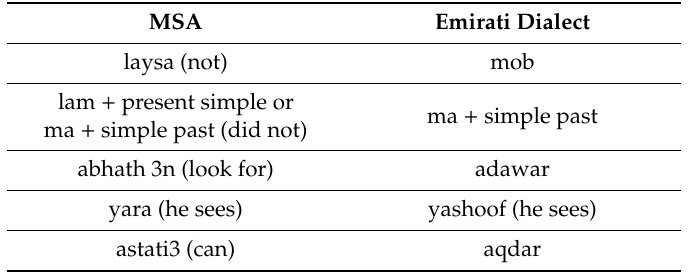
Table 3. Grammatical differences and different verbs in MSA and Emirati Dialect.